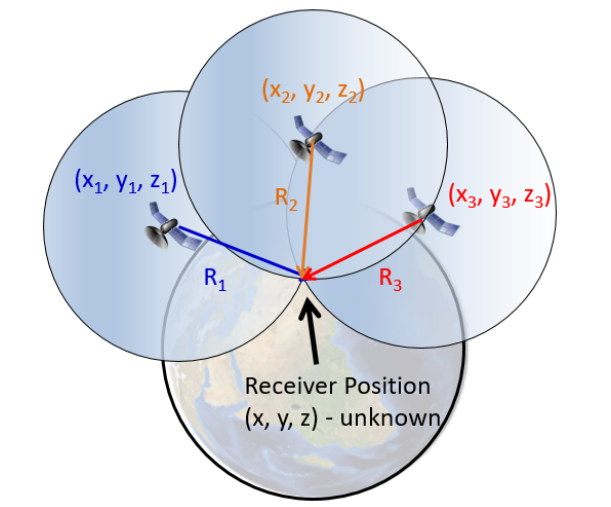
Figure 1. Trilateration principle of GNSS positioning.